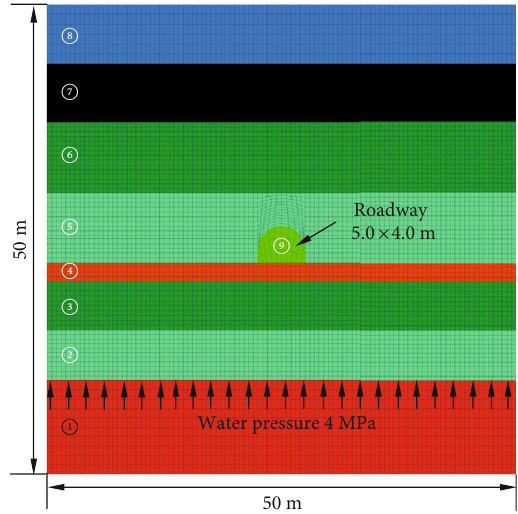
Figure 7: The numerical stress model of fl oor roadway in nonuniform stress fi eld under the in fl uence of water